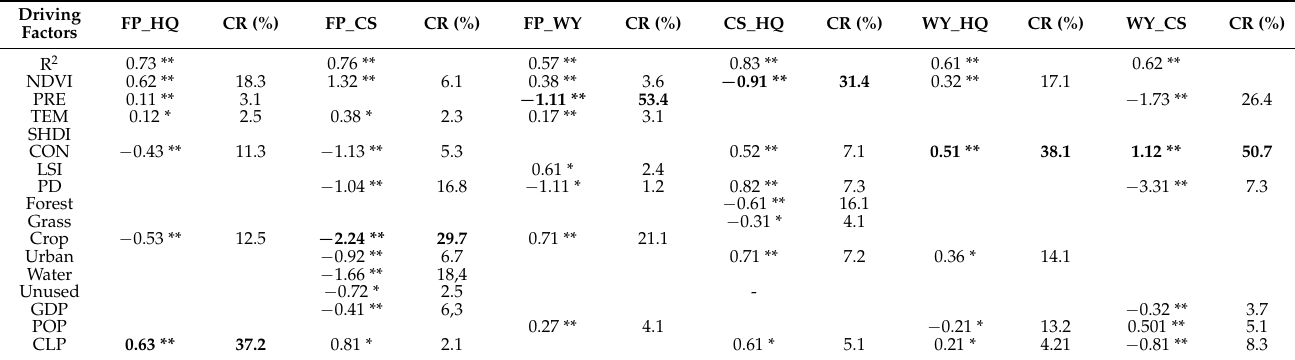
Table 4. Results of the 2000 automated linear modeling